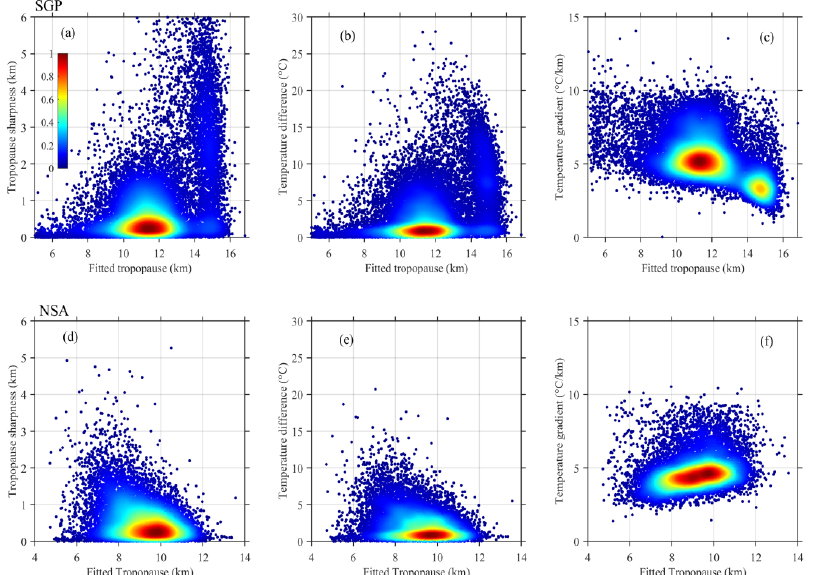
Figure 8. Density plots of the tropopause sharpness ( a ), temperature difference ( b ), and temperature gradient ( c ) as a function of the tropopause height at SGP; panels ( d ), ( e ) and ( f ) are similar to ( a ), ( b ) and ( c ) but at NSA. The color bar shows the data density of the scatter points, with larger values representing a higher data density.